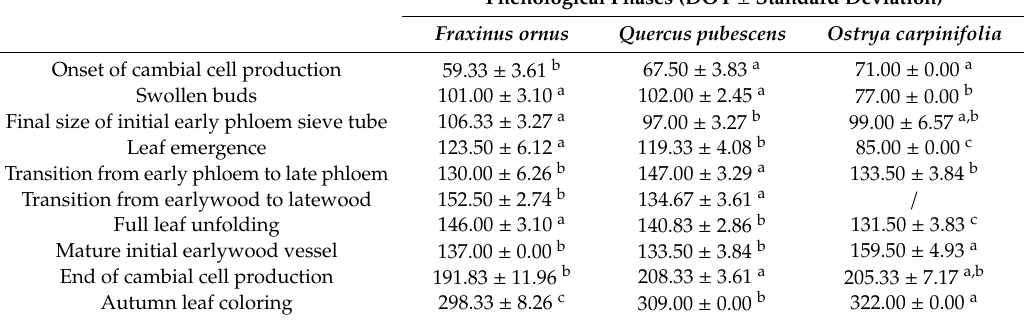
Table 2. Phenological phases (DOY = day of the year) of leaf development and of xylem and phloem formation (mean ± standard deviation). Phenological phases marked with the same letters are not significantly di ff erent ( α ≤ 0.05).